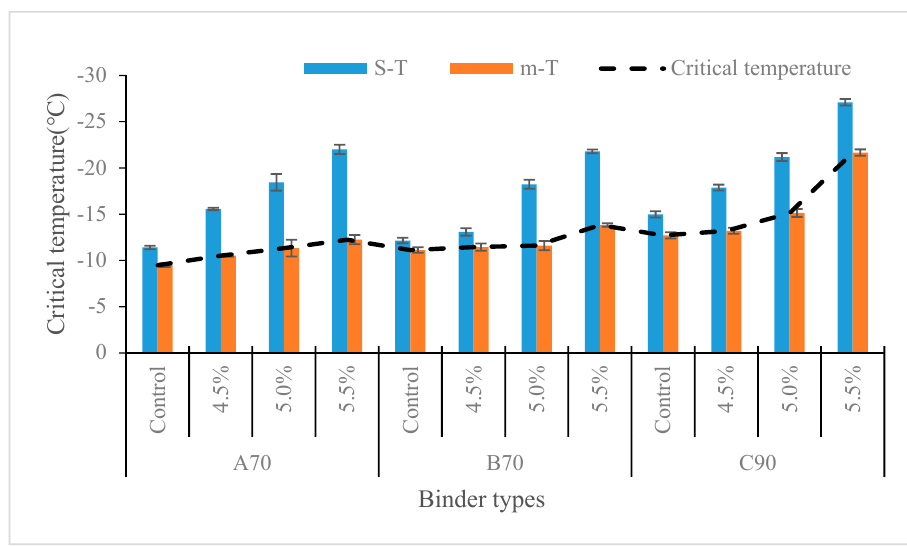
Figure 2. Minimum low temperatures of various binders. Note: S-T means stiffness modulus temperature; m-T means m value temperature.